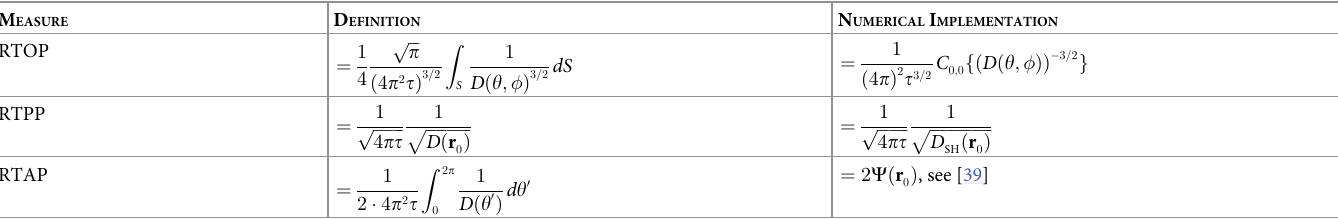
Table 1. Survey of the q-space measures gathered by AMURA, along with their specific numerical implementations. M